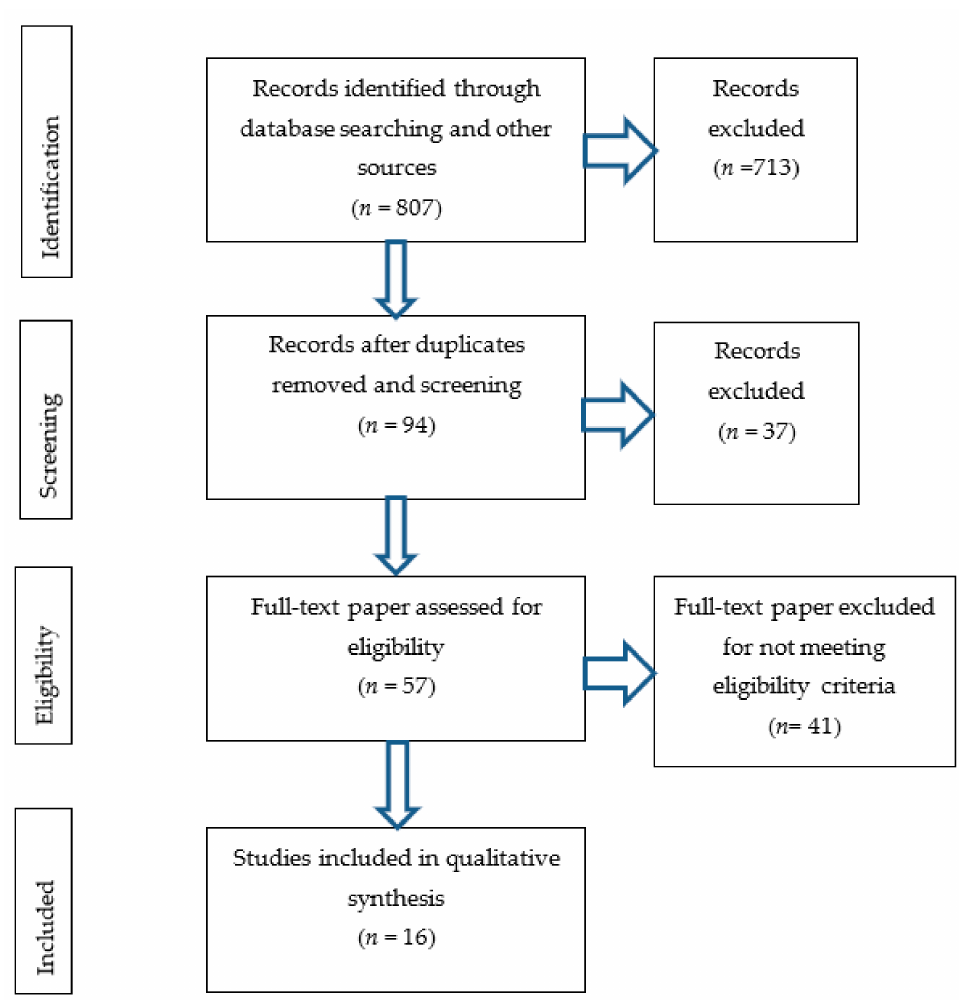
Figure 1. Flow diagram and search